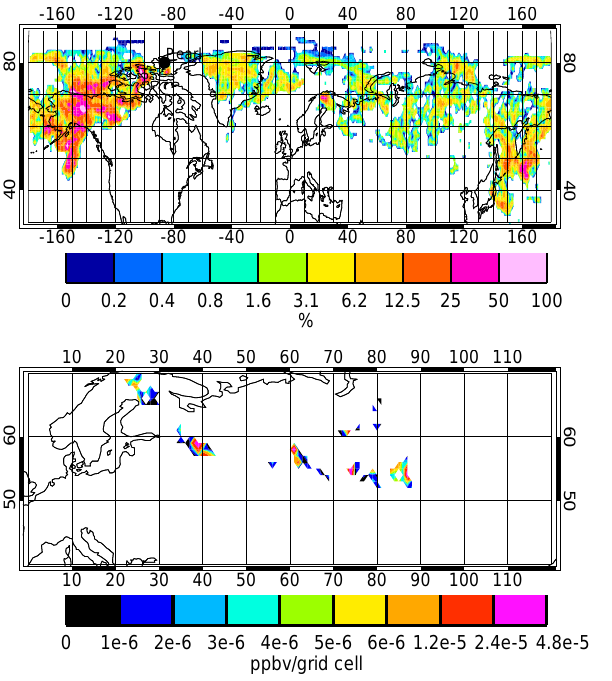
Fig. 12. Similar to Fig. 9, but for particles arriving at the recep- tor between 2 September 2006, 12:00UTC and 3 September 2006, 12:00UTC. Maximum residence time: